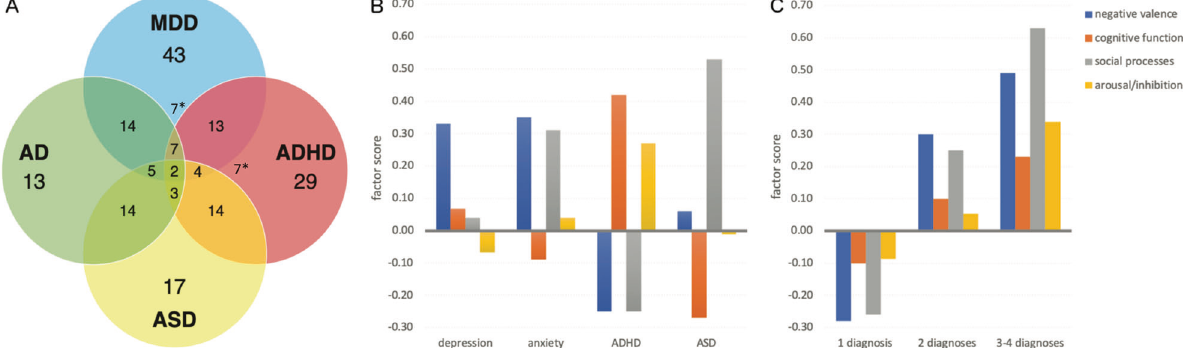
Fig. 1 Comorbidity and functional domains. A Diagram showing comorbidity within the data. *indicates comorbidity with the opposite disorder (MDD + ASD and AD + ADHD). B Normalized group-average subject loading onto the four functional domains in relation to diagnosis. C Normalized group-average subject loading onto functional domains in relation to degree of comorbidity. MDD major depressive disorder, AD anxiety disorder, ASD autism spectrum disorder, ADHD attention-de fi cit hyperactivity